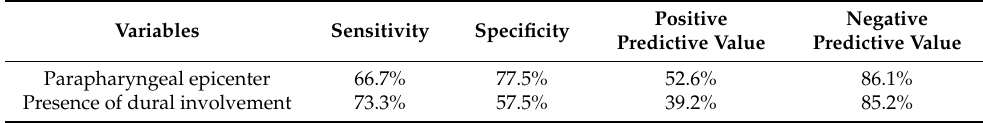
Table 7. Diagnostic performances of variables for differentiating GPA from